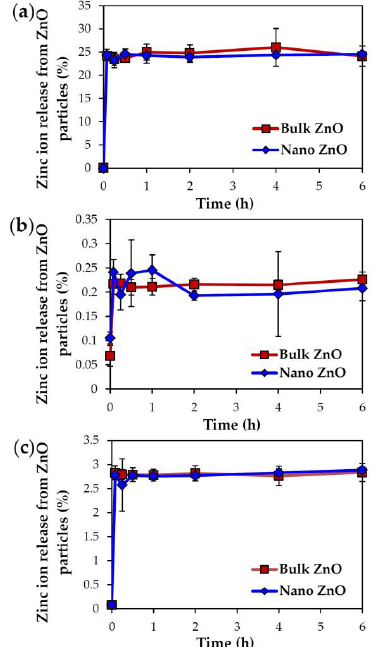
Figure 2. In vitro dissolution properties of ZnOs in simulated ( a ) gastric, ( b ) intestinal, and ( c ) plasma fluids. No significant differences between particle sizes were found ( p > 0.05).